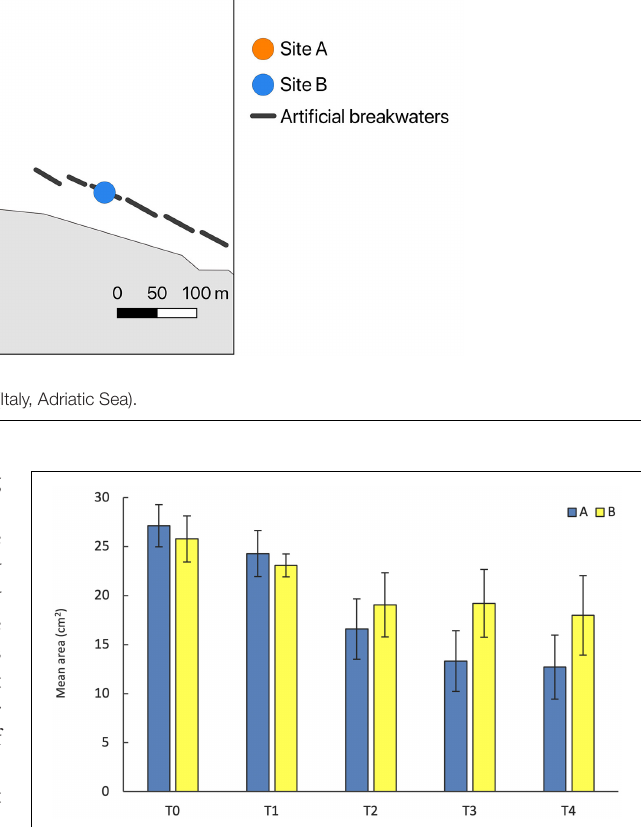
FIGURE 3 | Mean area ( ± standard error) of S. spinulosa reef fragments sampled at the two analyzed sites during five sampling times (T0 = September, T1 = February, T2 = July, T3 = October, and T4 =